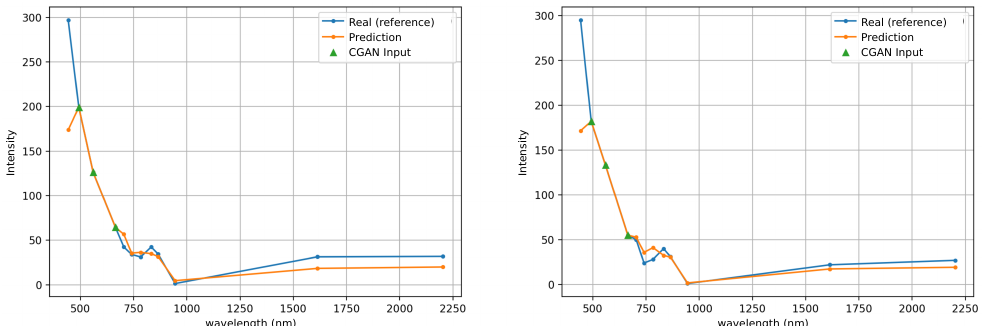
Figure 14. Average intensity of the pixels (( left ) plot) and wavelength of a random pixel (( right ) plot) of the multispectral image of the